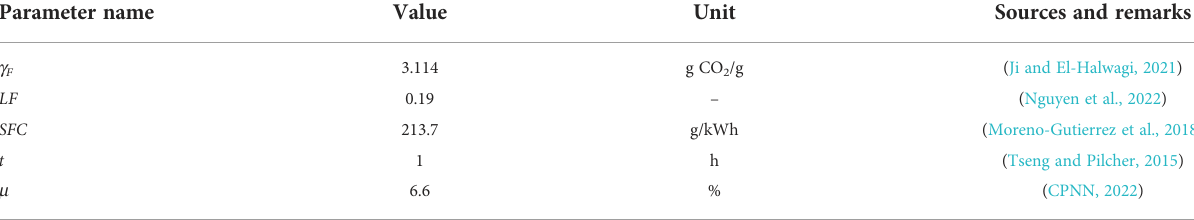
TABLE 4 Model parameter value.